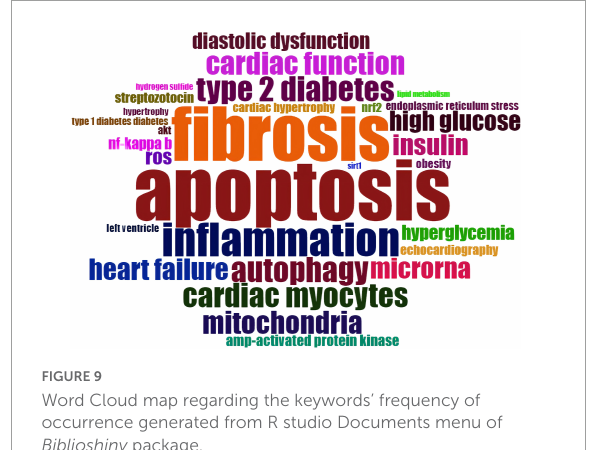
FIGURE9 Word Cloud map regarding the keywords’ frequency of occurrence generated from R studio Documents menu of Biblioshiny